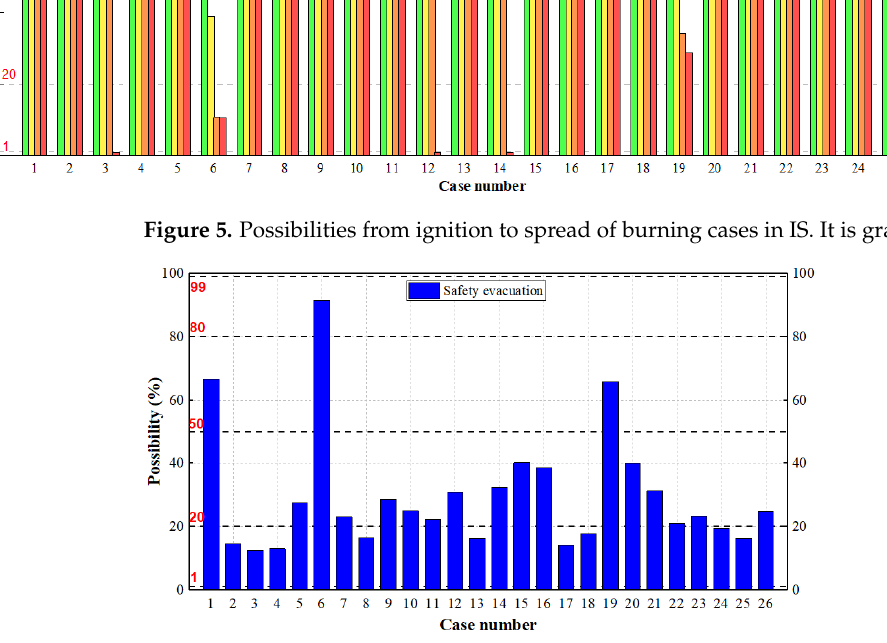
Figure 6. Possibilities for safety evacuation of burning cases in IS. The possibility of Case 6 is the highest.